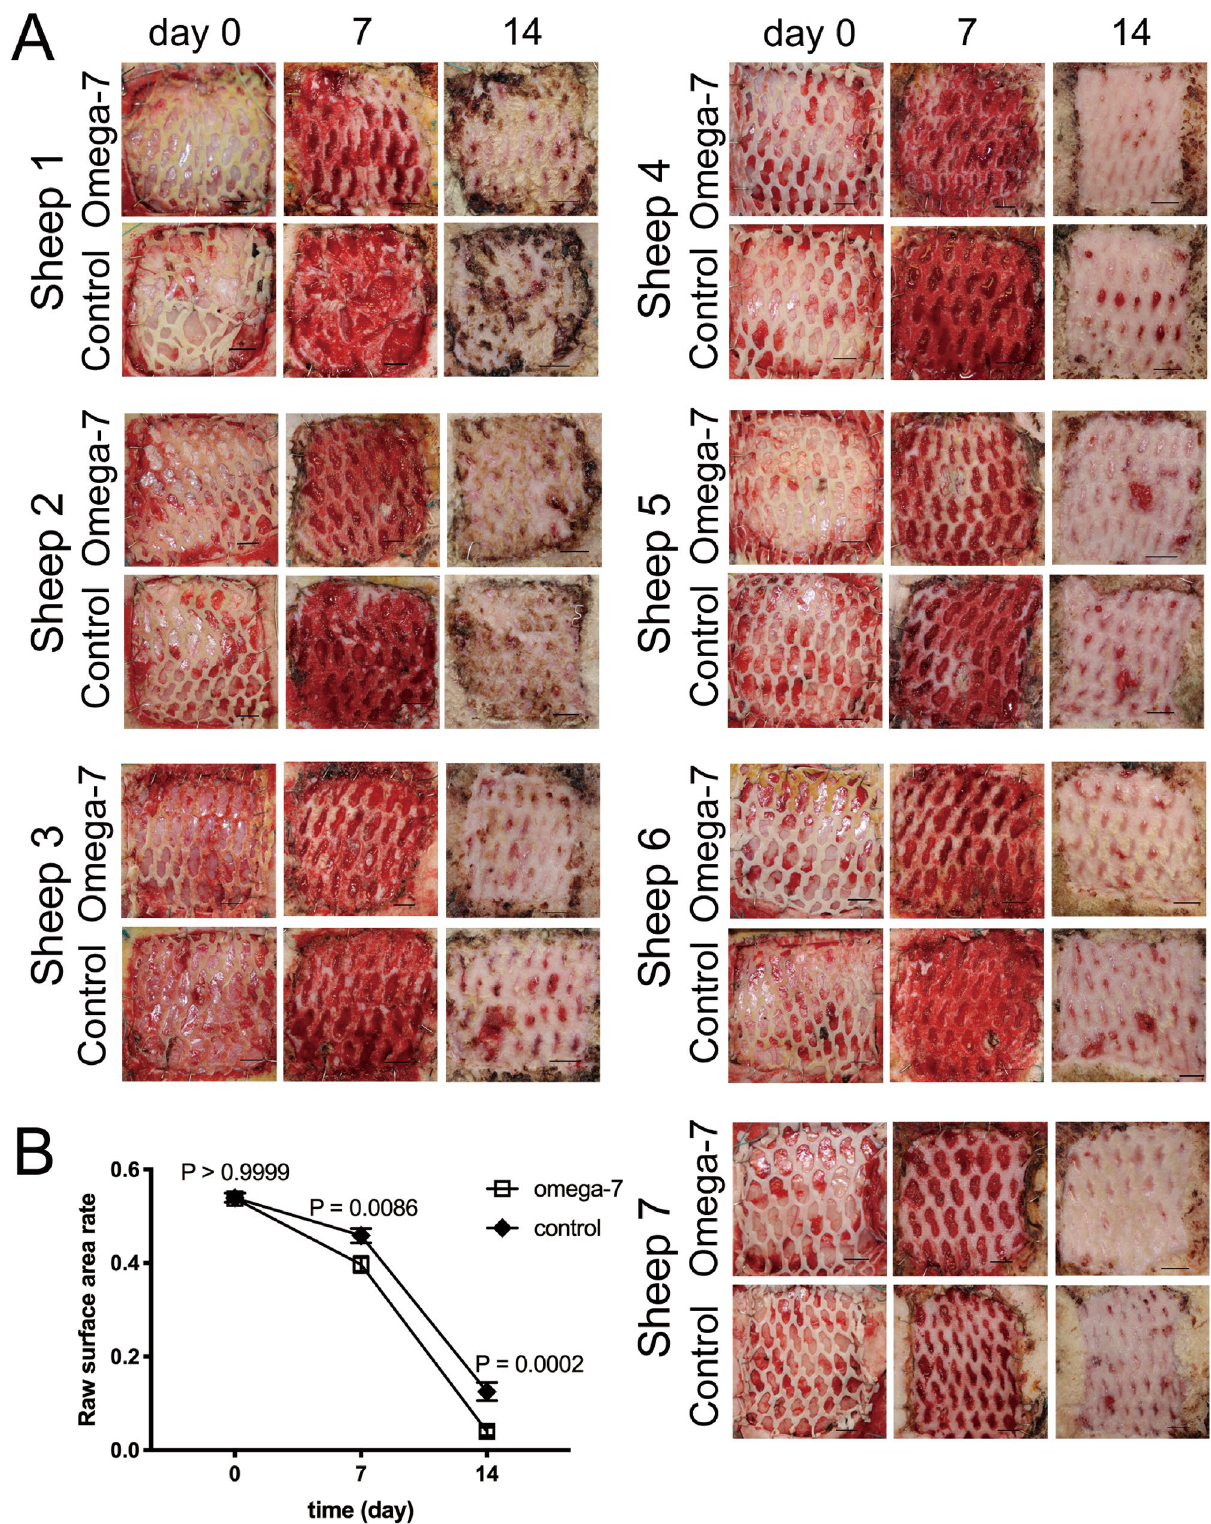
Figure 3. Effects of Omega-7 on ovine grafted burn wound healing. ( A ) Pictures of control and Omega-7- treated wounds in individual sheep at 0, 7 and 14 days. ( B ) Wound un-epithelialized surface area was measured by ultrasound and semi-quantified by Image J software. The raw surface area was measured in seven sheep. Each sheep had two treated and two untreated sites. Open circles indicate raw surface area in Omega-7, whereas closed circles indicate raw surface area in control sites. Data are expressed as mean ± SEM. Photographs taken and compiled, by authors, in Adobe Photoshop CC 2020 (https ://www.adobe .com/jp/produ cts/photo shop.html) without changing the content of images